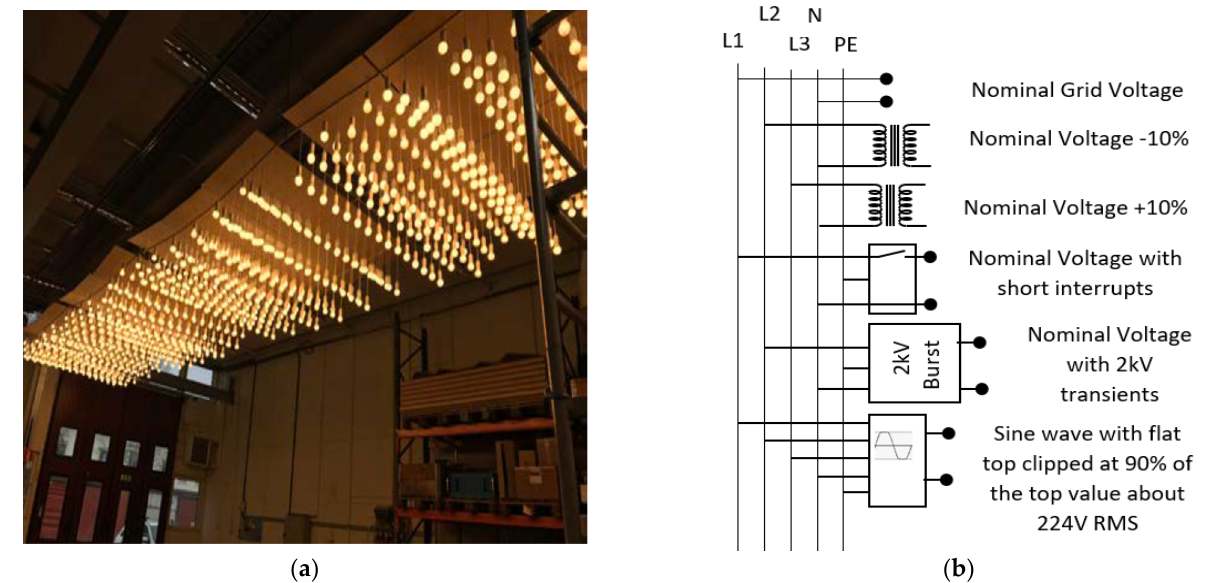
Figure 1. ( a ) One thousand and eighty lamps mounted on wooden boards hanging from the ceiling in the Pehr Högström laboratory at Luleå University of Technology in Skellefteå, Sweden. ( b ) Single line diagram.